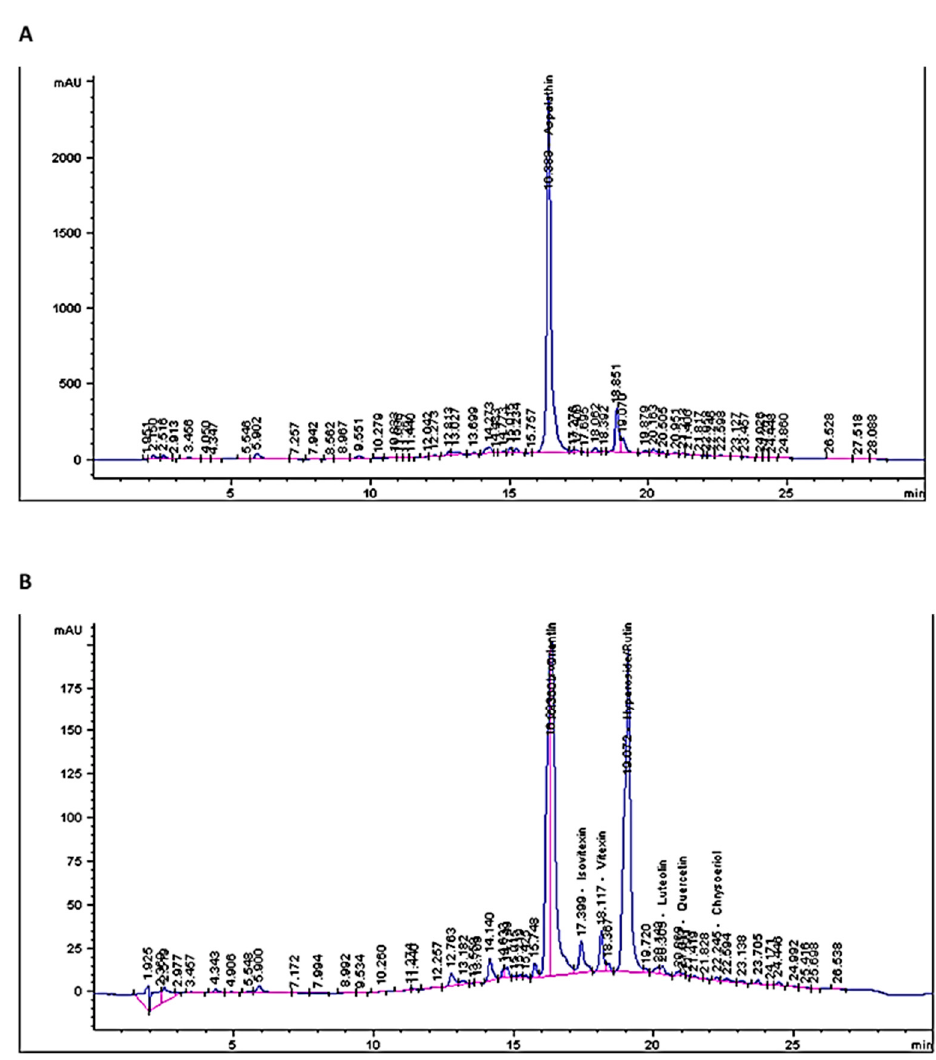
Figure 3. HPLC chromatograms of selected flavonoids of CGRE 15 mM: 40 °C: 60 min at 287 nm ( A ) and 360 nm ( B ).